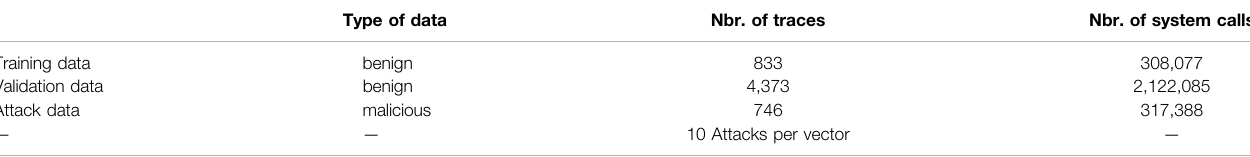
TABLE 2 | Structure of ADFA-LD (cf (Creech and Hu, 2013; Wunderlich et al., 2019)).